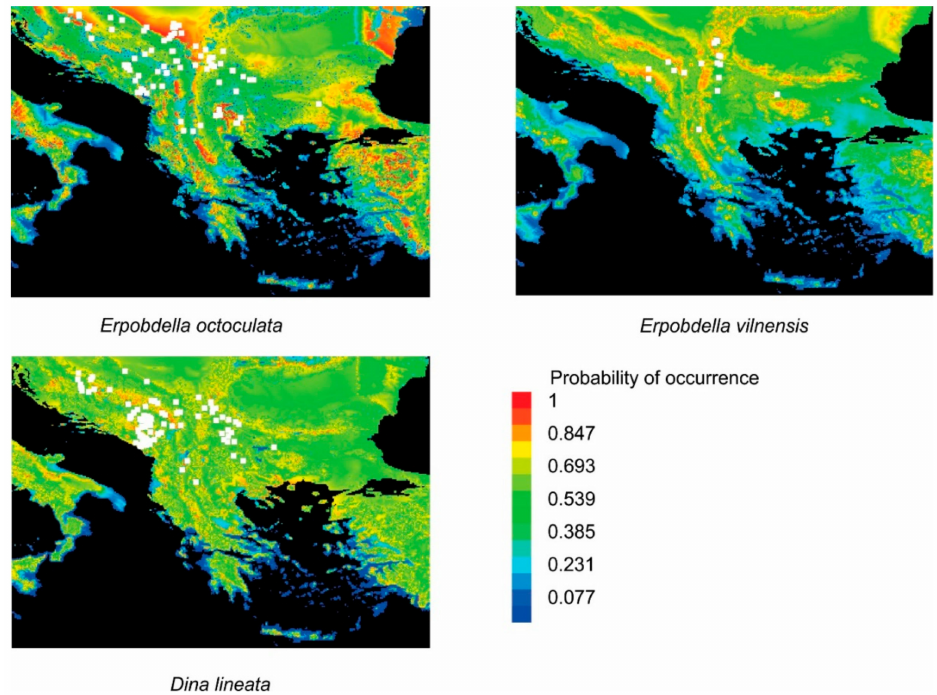
Figure 5. The potential distributions of the analyzed species, given by MaxEnt analyses.